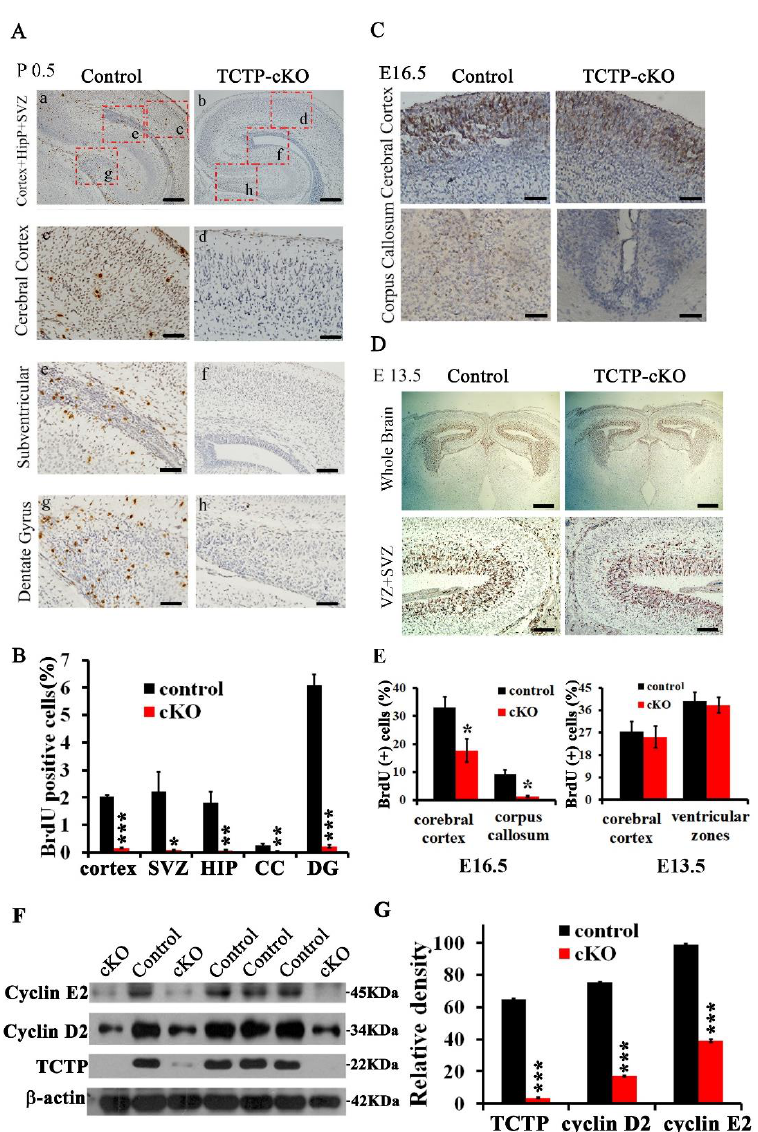
Figure 6. Cell proliferation and cyclin protein expression detected in brain sections and protein